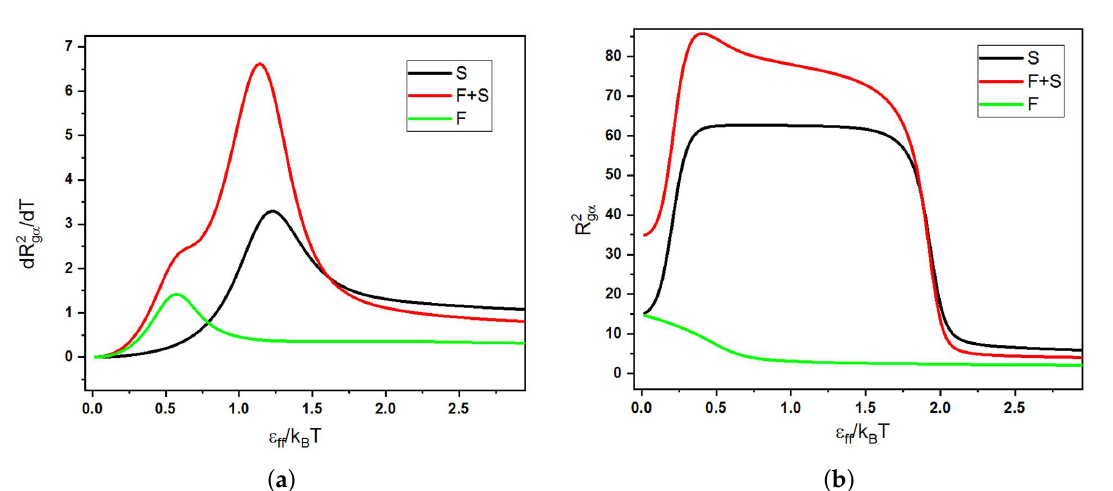
Figure 6. ( a ) Temperature dependence of the derivative of the squared gyration radius of the whole chain and of each block separately for b = 32 for a flexible copolymer ( ε st = 0). ( b ) Temperature dependence of the squared gyration radius for a semiflexible copolymer ( ε st = 20). Both figures are for the case “F-attract-stronger”. Data for the whole chain are denoted as F + S, and data for beads of each type separately are denoted as F and S,